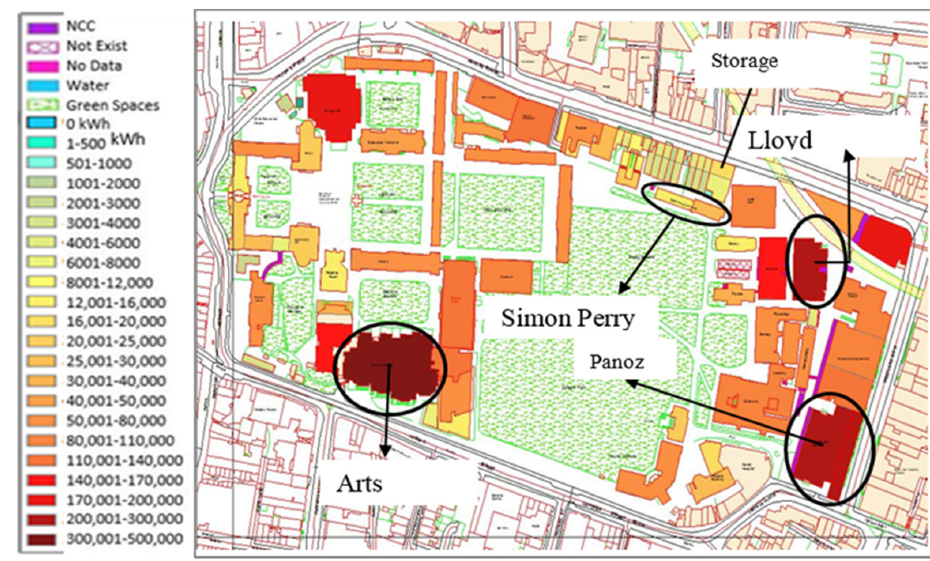
Figure 4. The heat demand (HM) map of January. Table 3. The thermal energy demand in August at the building level.